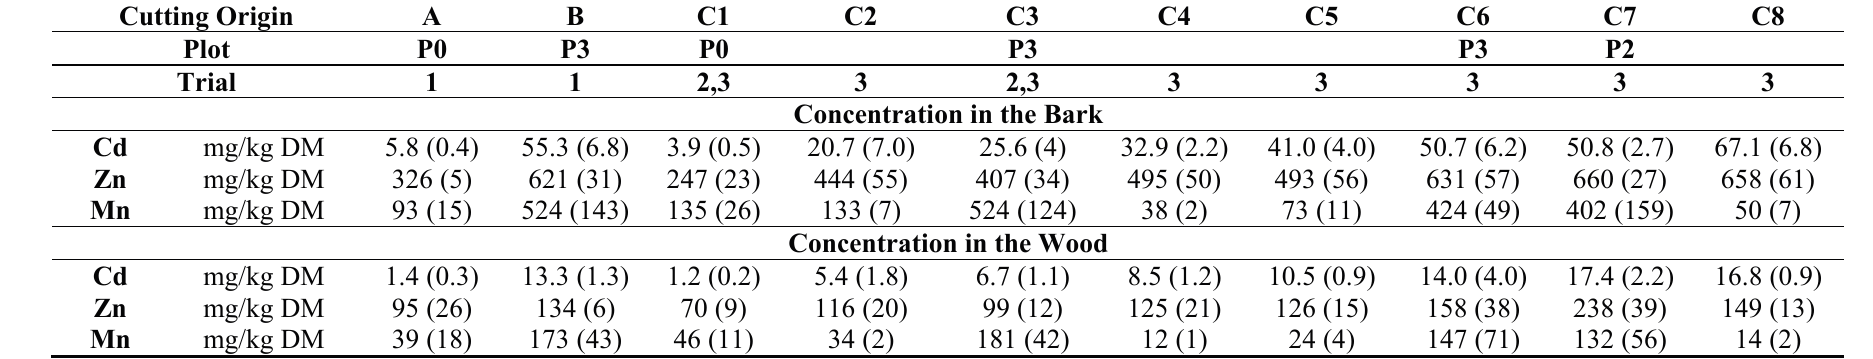
Table 5. Concentrations of Cd, Zn and Mn in the bark and wood of cuttings of the experiment on: (1) the translocation of metals from bark to shoot shortly after budburst; (2) metal translocation from cuttings to shoots versus metal uptake from soil; and (3) the experiment on the budburst of willow cuttings with increasing concentrations of Mn and Cd in the bark. Stem cuttings C1 to C8 were ranked from lowest to highest Cd concentration in the bark. Values are the averages of four replicates per type of cutting with standard deviation in brackets. The cuttings were collected at eight locations in the alluvial plain of the rivers Lys and Scheldt, i.e. , at 3 plots on the dredged sediment landfill site, at 1 plot on the reference location and at 4 other locations (A, cuttings from an uncontaminated location; B, cuttings from a contaminated location; C, cuttings from 8 locations; P, plot on the dredged sediment landfill or the reference location; DM, dry